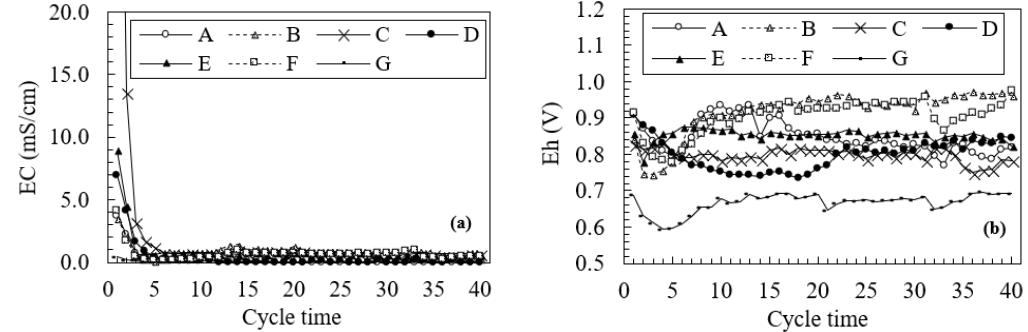
Figure 4. Changes in ( a ) electrical conductivity (EC) and ( b ) electric potential of the normal hydrogen electrode (Eh) over the 40 leaching cycles during the leaching test.